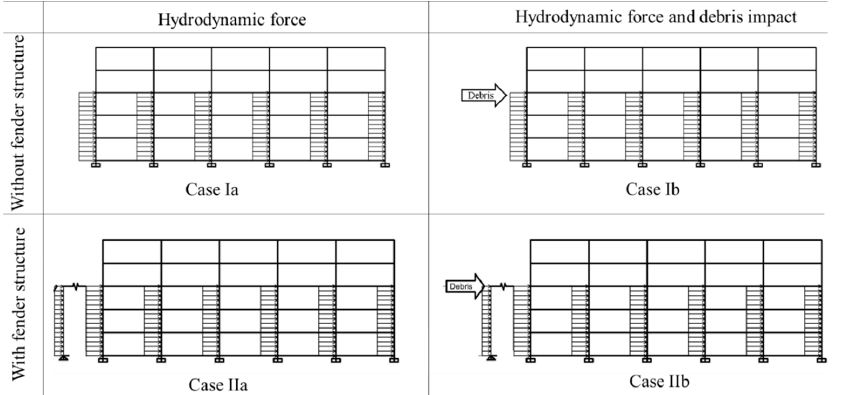
Figure 8. Building structures under different cases.